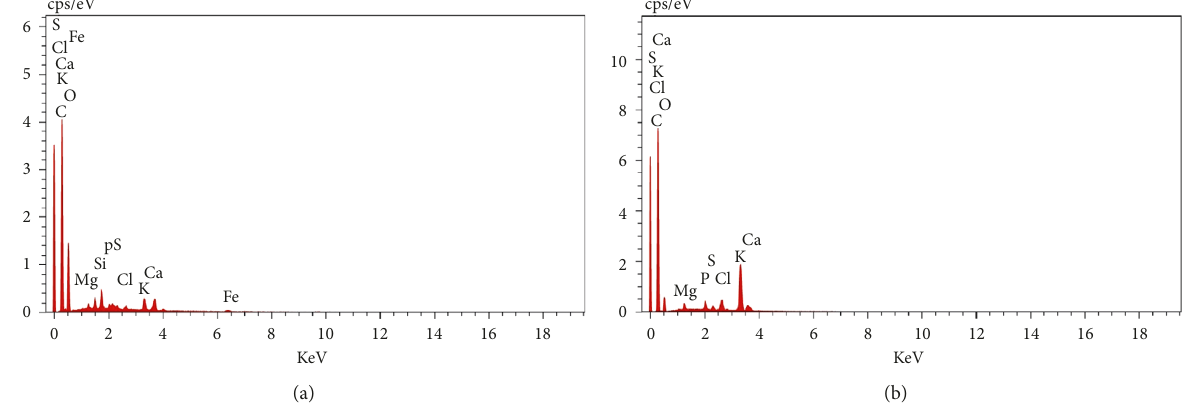
Figure 11: EDX analysis of (a) RPP and (b) BPP.